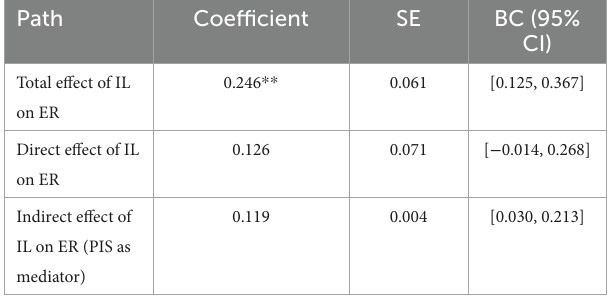
TABLE 5 Bootstrap analysis results of mediation effect.